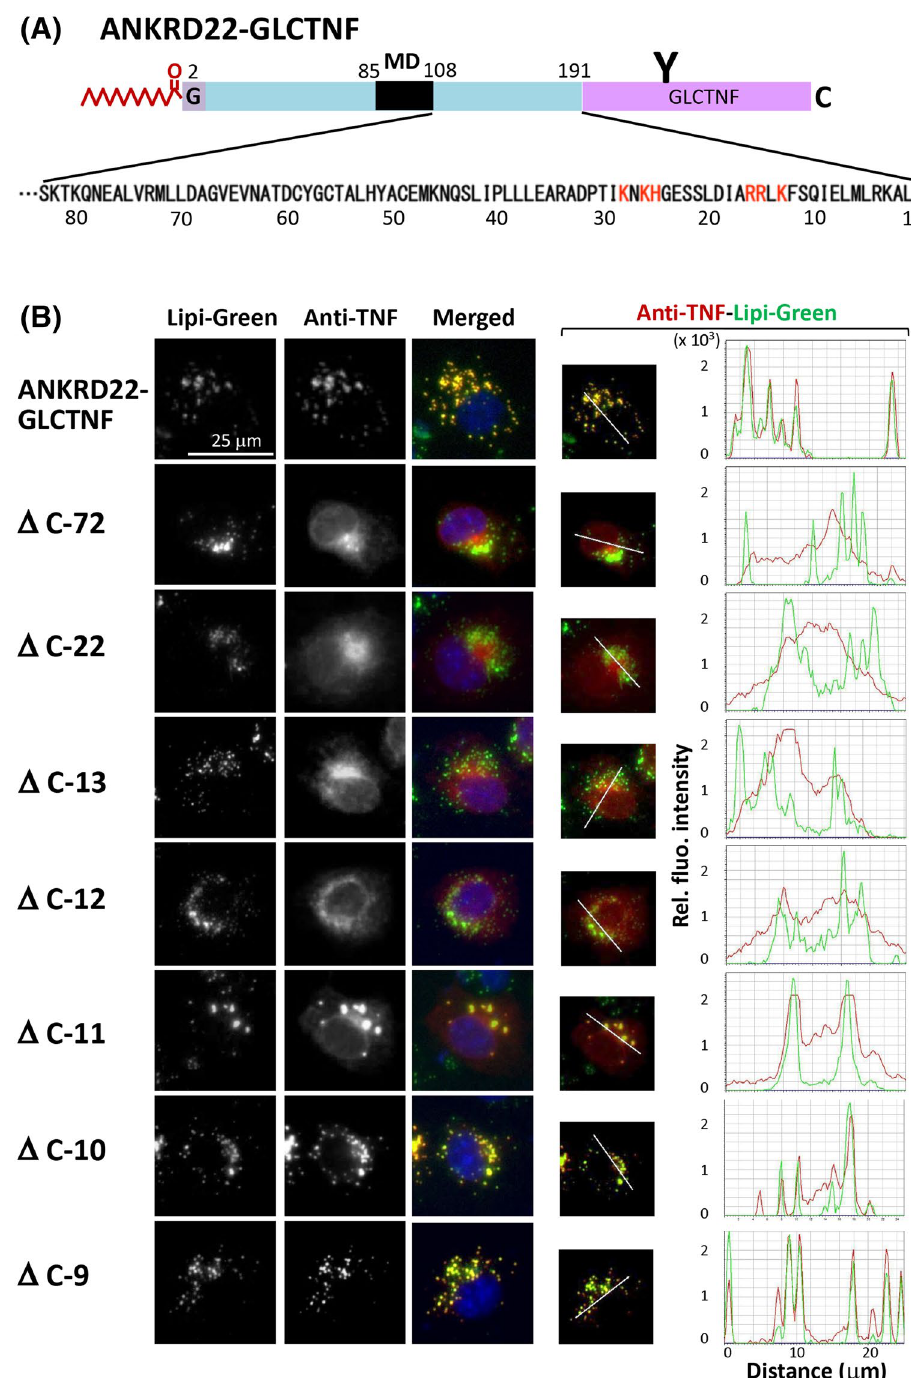
Figure 7. The C-terminal cytoplasmic domain plays important role in the localization of ANKRD22 to LD. The role of the C-terminal cytosolic domain in the intracellular localization of ANKRD22 was assessed by immunofluorescence microscopic analysis using a series of deletion mutants of ANKRD22-GLCTNF. The names and structure of the ANKRD22-GLCTNF mutants analyzed in Fig. 7 are summarized in Supplementary Fig. S6[1]. The experiments were repeated 3 times and the similar results were obtained. A representative data was presented. ( A ) The amino acid sequence of the C-terminal cytosolic domain of ANKRD22 was shown. Two positively charged amino acid clusters analyzed in Fig. 8. were indicated by the red characters in the amino acid sequence. ( B ) Effects of deletion of the C-terminal cytosolic domain on the intracellular localization of ANKRD22-GLCTNF. Fluorescence images obtained by immunofluorescence analysis and the results of the line profile analysis were shown. For the line profile analysis, corresponding line-scan graphs of the relative fluorescence intensities of green fluorescence (green line) and red fluorescence (red line) along the white line indicated in the merged images are